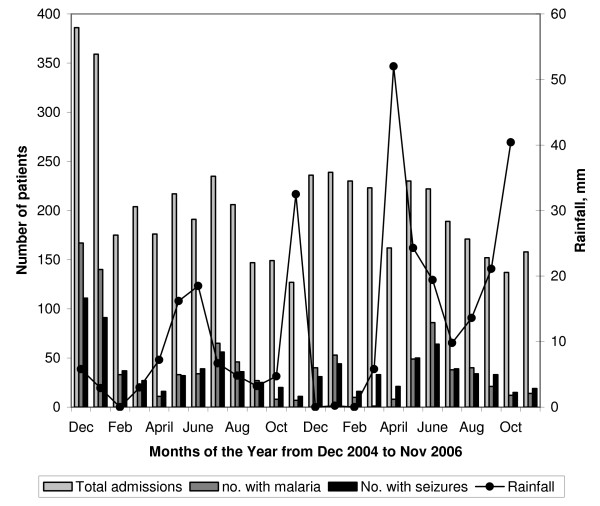
Monthly admissions with malaria, seizures and rainfall in Kilifi. Total monthly admissions, admissions with malaria and seizures, and rainfall: The number of patients admitted with seizures has a seasonal pattern with peaks in December-January (after the short rains) and May-August (after the long rains). These peaks coincide with that for patients with presenting with malaria.